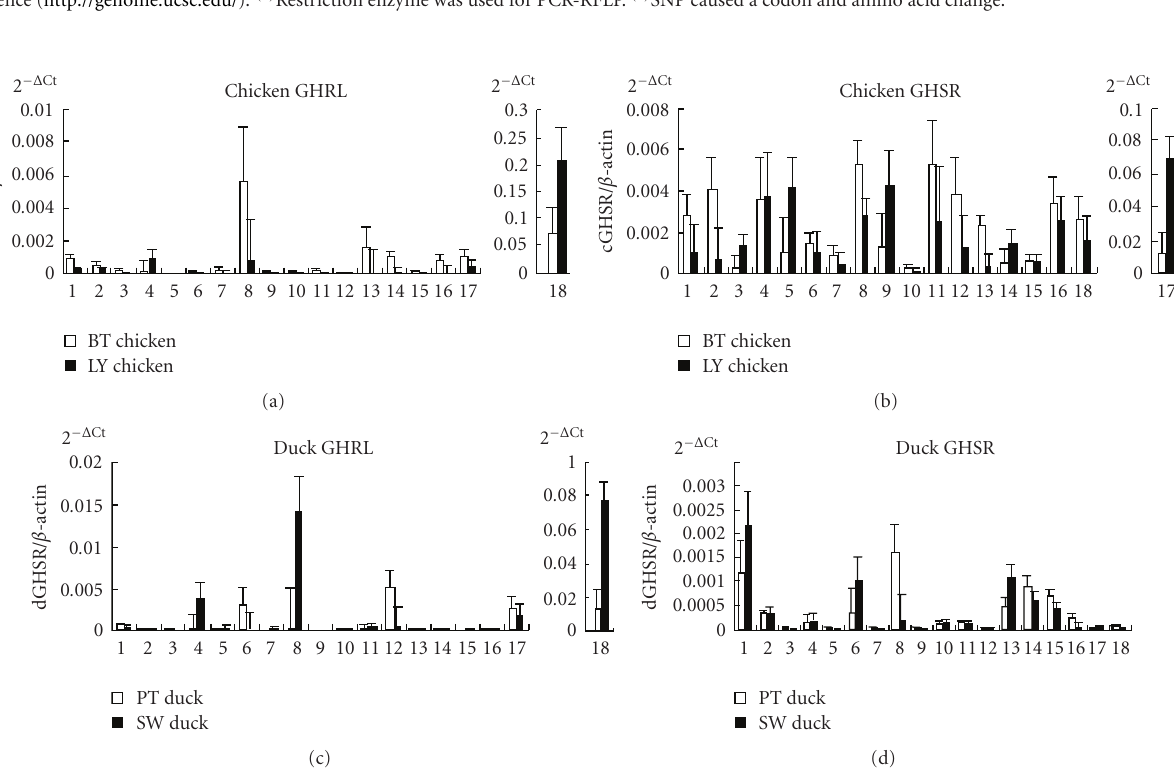
Figure 4: Relative mRNA expression levels of the GHRL and GHSR genes in adult chicken and duck tissues. The vertical axis indicates the 2 − Ct value (mean ± S.E.M., n = 6). Pituitary, Cerebrum, Lung, Abdominal fat, Liver, Testis, Gizzard, Subcutaneous fat, Spleen, Kidney, Leg muscle, Uropygial gland, Hypothalamus, Small intestine, Cerebellum, Heart, Breast muscle, and Proventriculus are